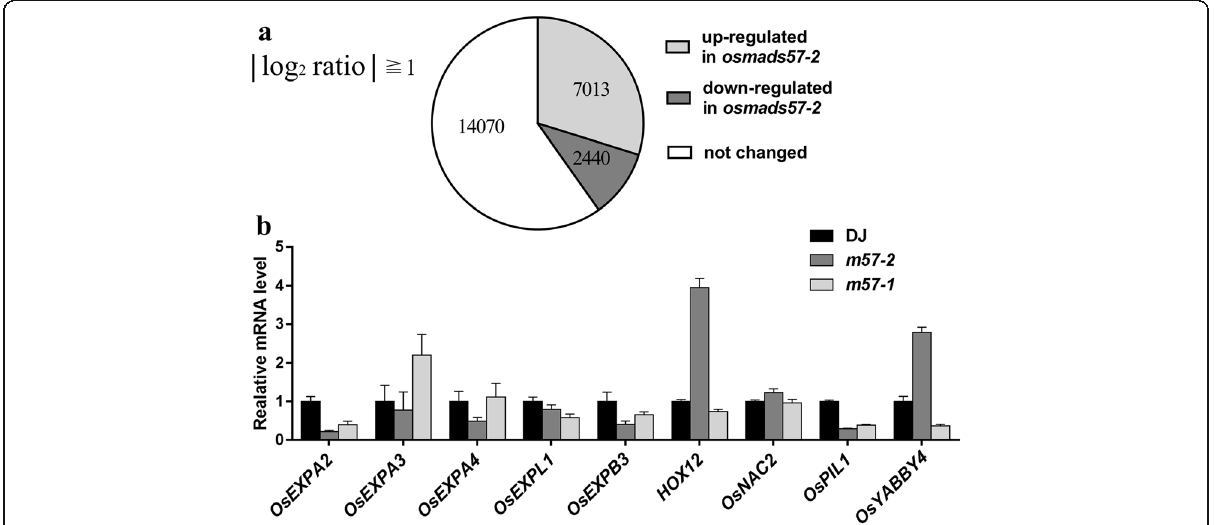
Fig. 6 Expression analysis of genes involved in GA metabolism and cell wall loosening. a Expression changes of genes in m57 – 2 seedlings from the RNA-seq analysis. b Expression of genes involved in GA metabolism and cell wall loosening in mutants and wild-type lines was analysed by Q-PCR. DJ, wild type; m57 – 2 , osmads57 – 2 ; m57 – 1 , osmads57 – 1 . Three independent experiments were conducted with similar results. Data are means± SE ( n = 12). Error bars indicate